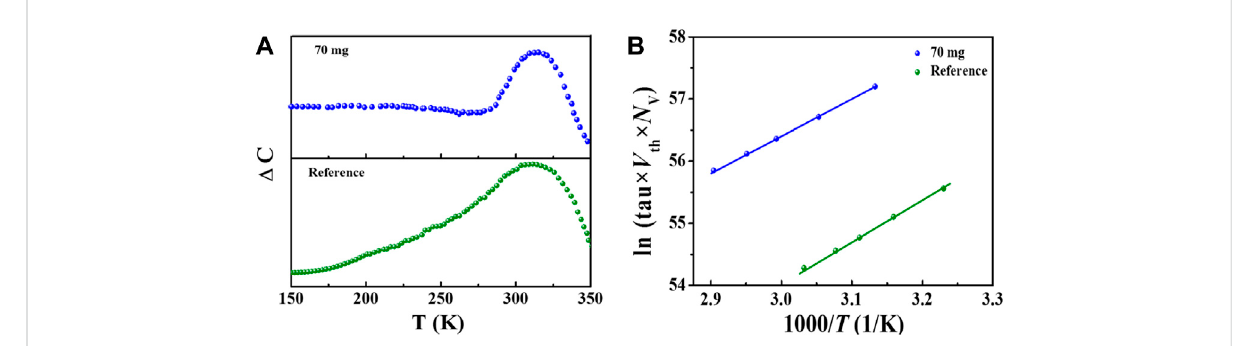
FIGURE 6 (A) DLTSmeasurements of thechampion pristine CZTSSe device and Sbdoped-CZTSSe device, (B) Arrhenius plotscorresponding to thepeaks derived from the DLTS